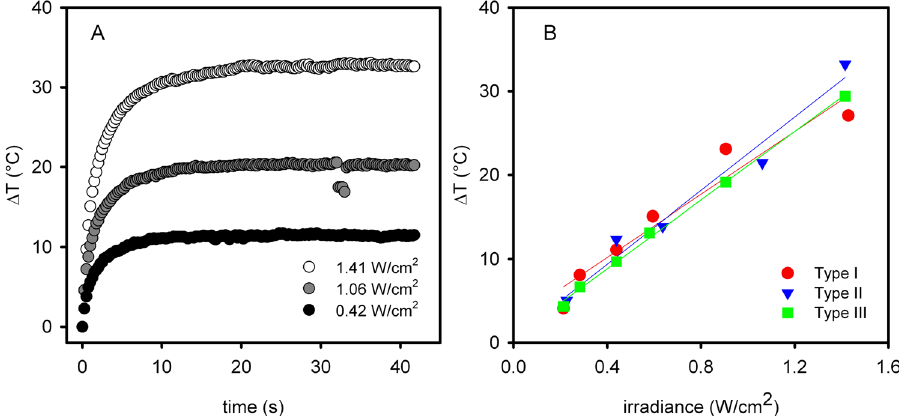
Figure 4. ( A ) Thermograms ( Δ T vs time) for Type III surface irradiated with 800 nm laser, measured at different irradiance values (irradiance calculated considering a circular beam cross section, with a 3 mm beam waist). ( B ) stationary Δ T vs irradiance for Type I-III surfaces (solid lines are linear regressions).